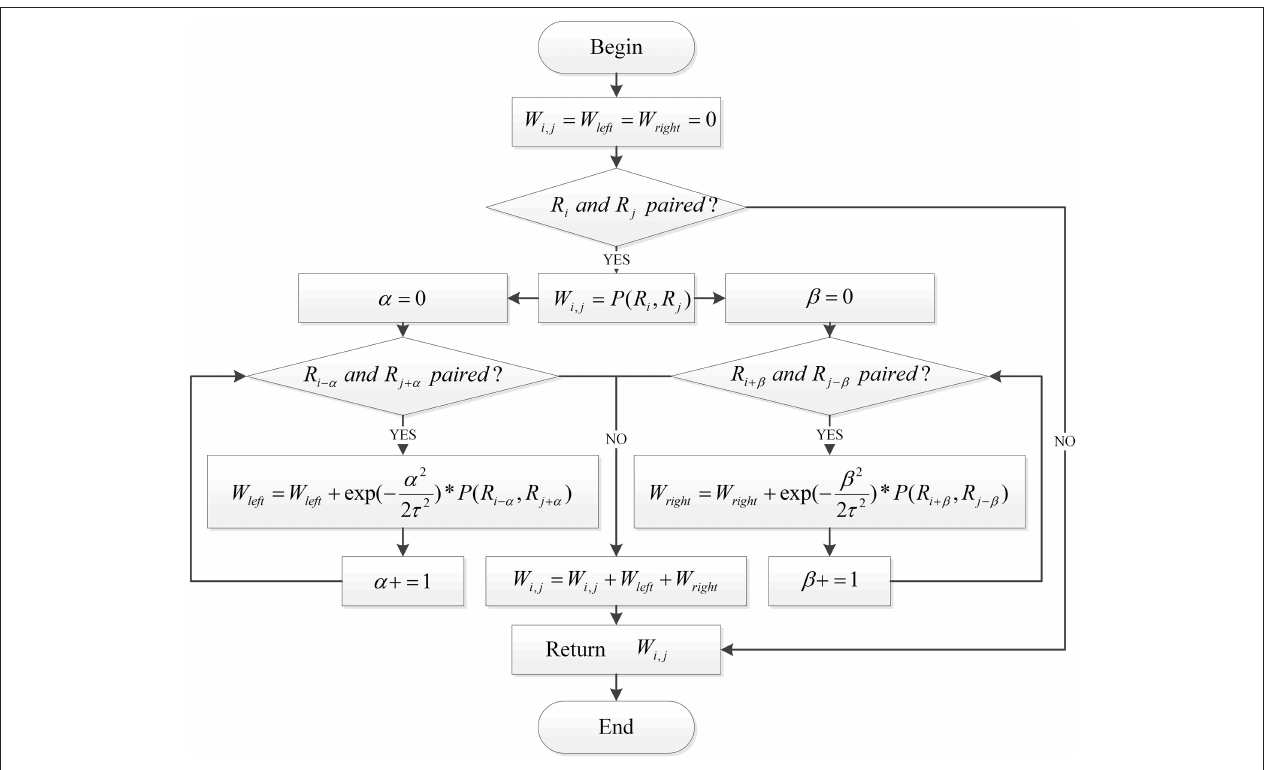
FIGURE 2 | The process of RNA matrix representation based on RNA sequence